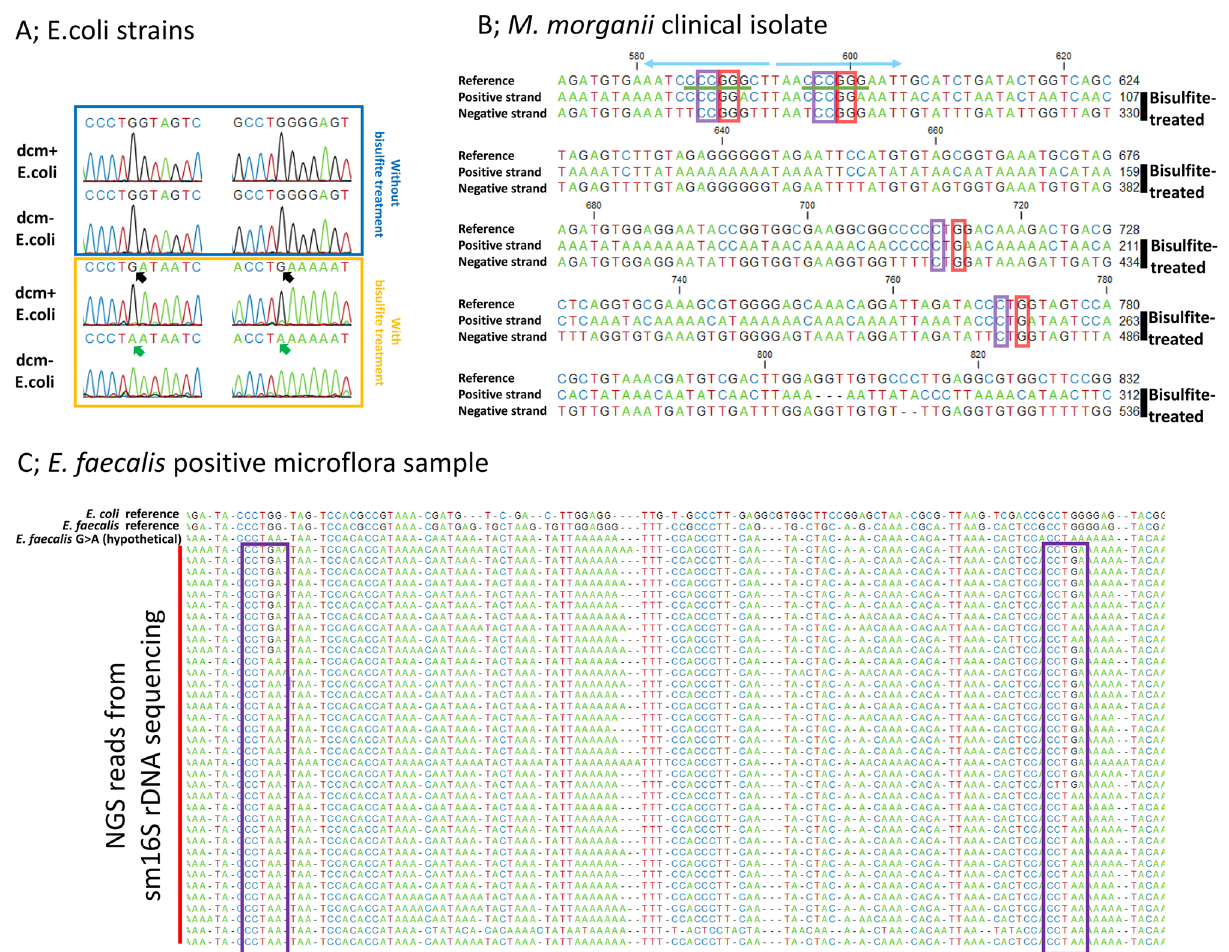
Figure 2. Sequencing the sm16S rDNA PCR product from clinical isolates and microflora simultaneously provides rDNA sequence information and methylation status. Extracted DNA was converted with bisulfite treatment and amplified with MDAwoDD. DNA without bisulfite treatment was amplified using conventional MDA. Bisulfite PCR was performed using MDA products as templates, and the resulting PCR products were sequenced. ( a ) Sanger sequencing of bisulfite PCR products from genomic DNA of dcm+ and dcm− E. coli . The left side of the figure shows a typical CC(A/T)GG site targeted by dcm methylase and the right half shows another typical CC(A/T)GG site. The difference between dcm+ and dcm− E. coli becomes apparent with bisulfite treatment, as shown by the black and green arrows. Green arrows indicate G to A conversion resulting from bisulfite conversion and unmethylated cytosine in the negative-sense strand. The black arrow (not converted) indicates the existence of 5-methylcytosine in the negative-sense strand. ( b ) Summary of bisulfite sequencing from a clinical isolate of M. morganii . The red boxes indicate 5-methylcytosine in the negative- sense strand. The purple boxes indicate 5-methylcytosine in the positive-sense strand. Note that the four methylated residues at the two SmaI sites (CCC GGG ) are underlined in green. The four methylation residues exist in a palindrome-like structure, as indicated by the light blue arrows. The reference sequence was retrieved from NCBI NR_028938.1. c) Sequence reads implicating diversity in genomic DNA methylation status of E. faecalis from a microflora sample. Sequencing of amplicons from MDAwoDD products indicated diverse DNA methylation at the CC(A/T)GG site (purple boxes) of the genomic DNA fragment that appears to be from E. faecalis in sample number 10_1379 (Supplementary Table 1). In the purple boxes, the Gs written in black in the bisulfite-converted sequences indicate 5-methylcytosine in the negative-sense strand. The reference sequences in the top two columns were retrieved from NCBI NC_000913 ( E. coli ) and NCBI NR_114782.1 ( E. faecalis ) and are the intact sequences, not the bisulfite-converted ones. E. faecalis G>A (hypothetical) sequence in the third column from the top was generated by simply substituting nucleotides, assuming that all cytosines are unmethylated and subject to bisulfite